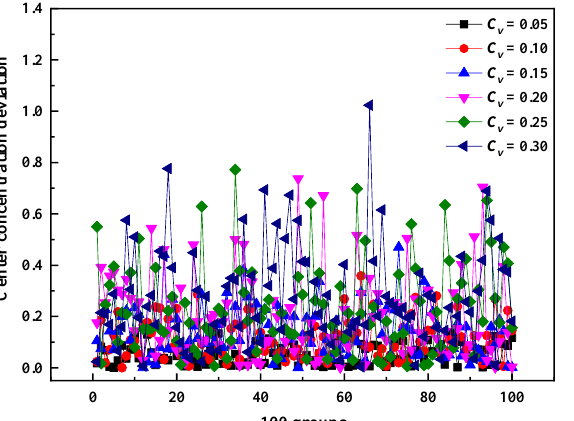
Figure 28. Center concentration deviation under different relative standard deviations of velocity at velocity 3.2 m/s.